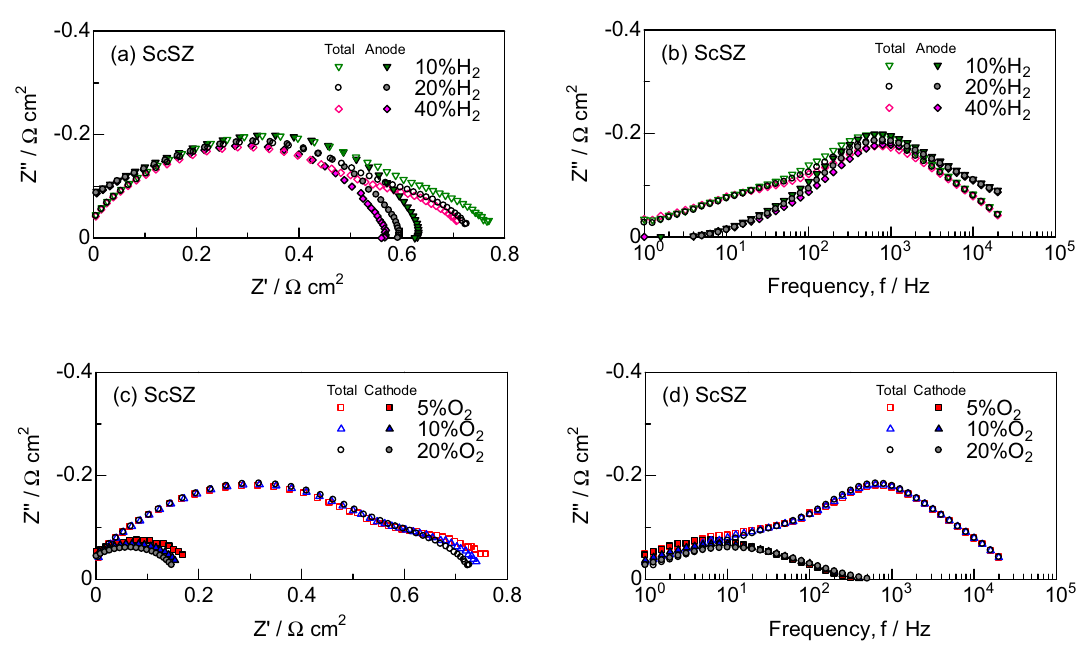
Figure 2. IR-free impedance spectra at 700 °C in ( a , b ) the constant oxidant of O 2 :H 2 O:N 2 = 20:3:77 vol.% and ( c , d ) the constant fuel of H 2 :H 2 O:N 2 = 20:3:77 vol.% for SOFCs supported on ScSZ